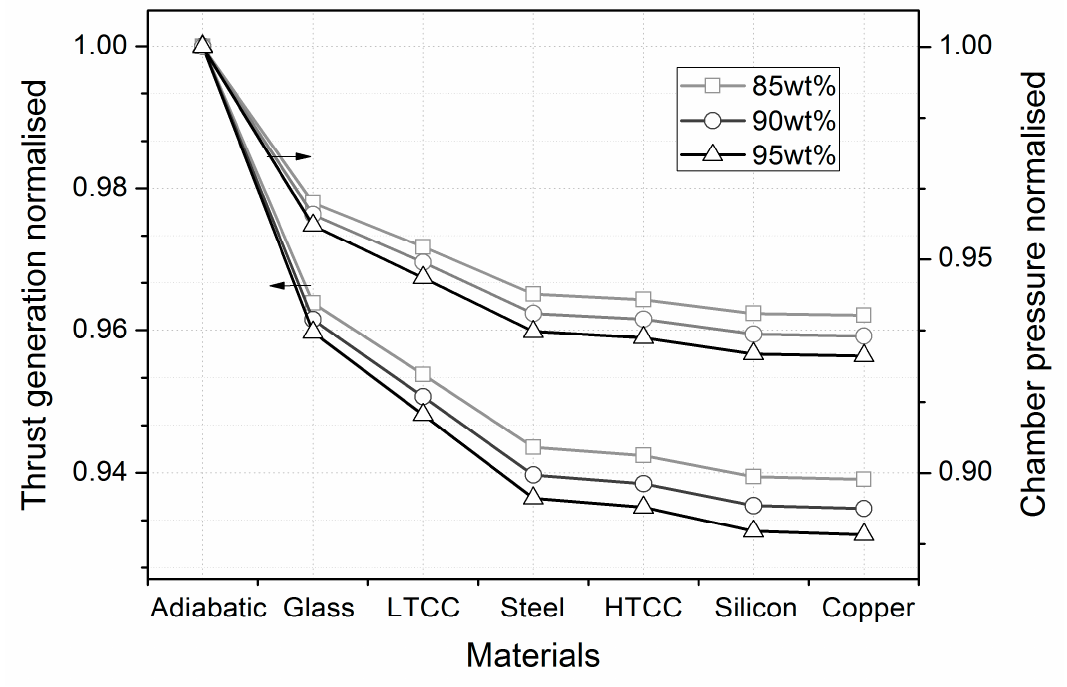
Figure 15. Normalized amount of thrust generation and chamber pressure of the microthruster in relation to various structural materials and propellant weight percentages.